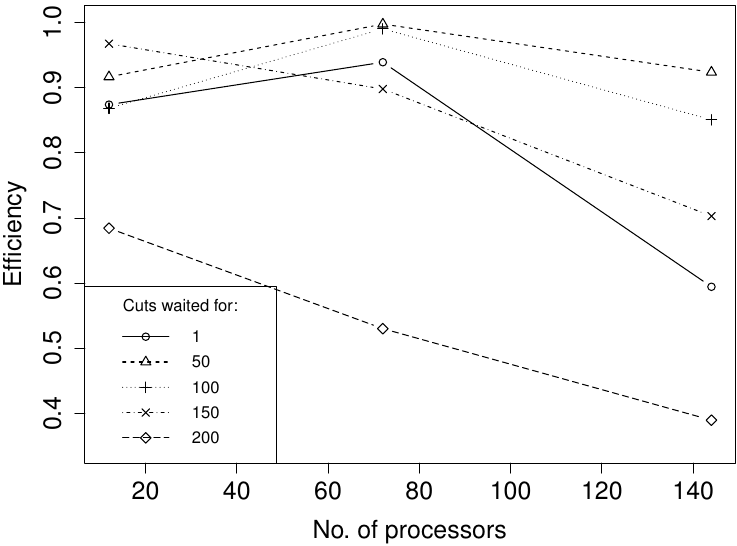
Figure 6. Parallel efficiency as a function of the number of processors for Case 2. Each line corresponds to a separate choice of N W